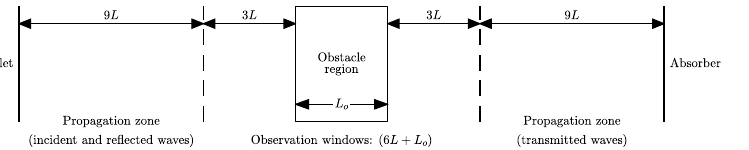
Figure 2. Layout of the present 2D numerical wave flume. L o = length of the obstacle (see Figure 1). L = wavelength of the incident